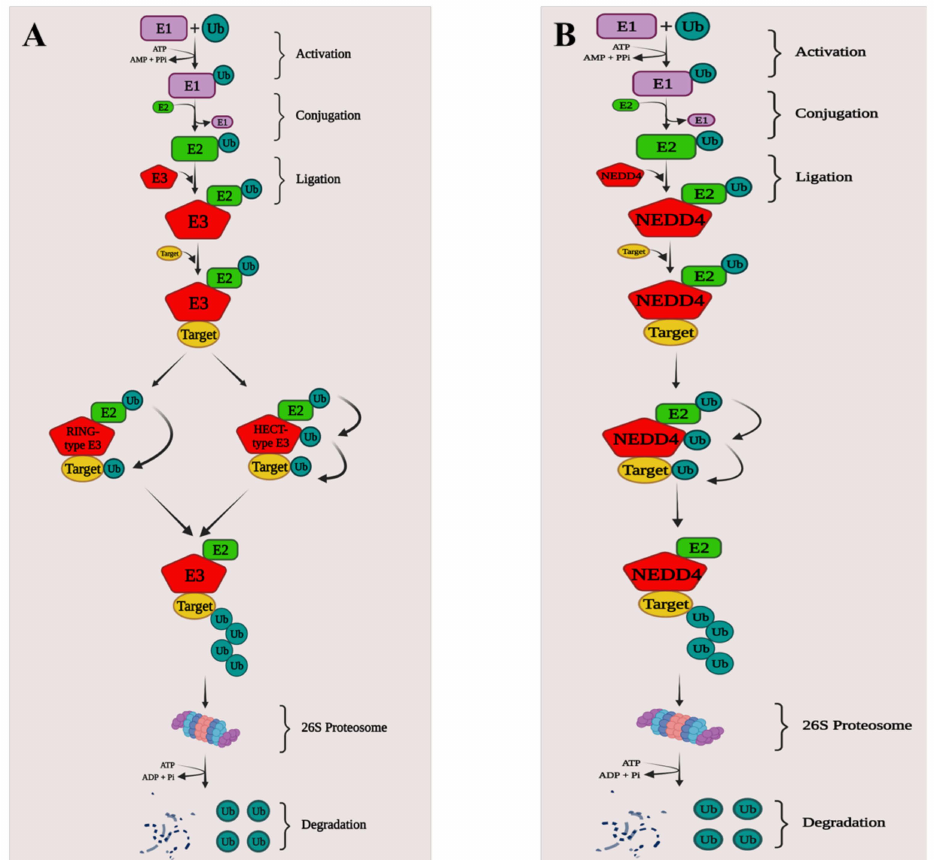
Figure 1. Mechanistic role of E3 ligases ubiquitinating target substrates . ( A ) The E1, E2, and E3 catalyze ubiquitination. E1 activates ubiquitin in an ATP-dependent manner before transferring it to E2. E2 then transfers the ubiquitin to E3 which in turn transfers to target substrates for degradation by the 26S proteasome. In the case of RING-type E3s, the transfer of ubiquitin to the target substrate requires an intermediate complex of the target, E3, E2, and Ub. For HECT-type E3s, prior to ubiquitin transfer to the target, E2 with Ub binds and transfers the ubiquitin to the E3. ( B ) NEDD4 is a HECT- type E3 ubiquitin ligase, ubiquitinated by E2, which then transfers the ubiquitin to the target substrate leading to the degradation by the proteasome. Created using